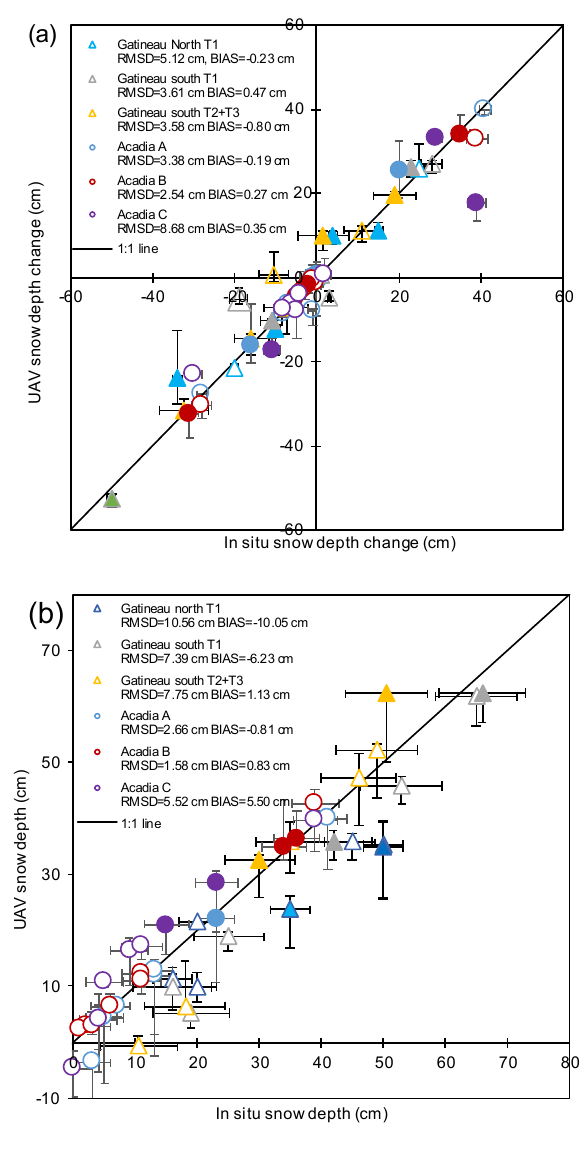
Figure 7. Validation of (a) snow depth change for successive ( ∼ weekly) measurements and (b) corresponding snow depth over tran- sects. Shaded symbols correspond to icy or fresh snow conditions. Horizontal (vertical) bars correspond to the ± 34th percentile inter- val of within-transect in situ (UAV) snow depth